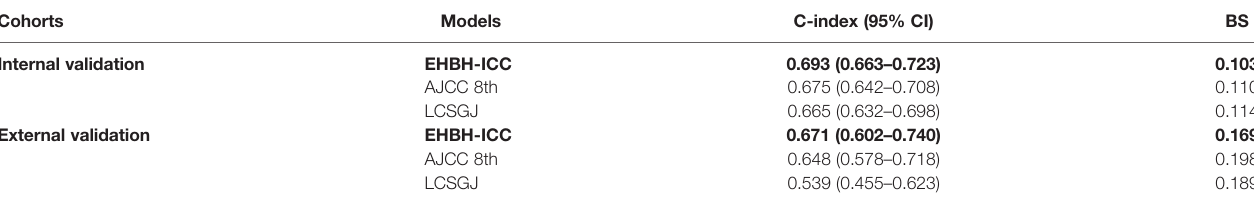
CI,con fi denceinterval;BS,brierscore;EHBH-ICC,theprognosticscoringsystemforpostoperativeintrahepaticcholangiocarcinomaproposedbyEasternHepatobiliarySurgeryHospital; AJCC 8th, the 8th edition of the American Joint Committee on Cancer staging system; LCSGJ, the Liver Cancer Study Group of Japan staging